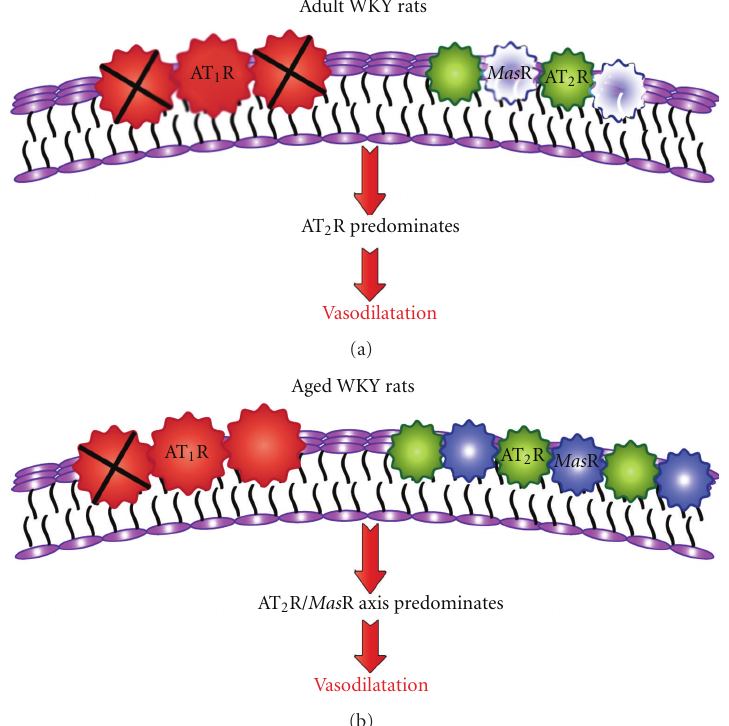
Figure 6: Schema depicting di ff erential mechanisms of Ang (1-7)-mediated vasodepressor e ff ect in adult and aged candesartan-treated rats. AT 1 R expression was similar in aortae from adult and aged rats whereas there was upregulation of AT 2 R, MasR, and ACE2. Therefore, a lower level of AT 1 R blockade with candesartan ( X ) was required in aged animals (b) compared with adult animals (a) in order to unmask the vasodilator axis. MasR was not functionally active in adult